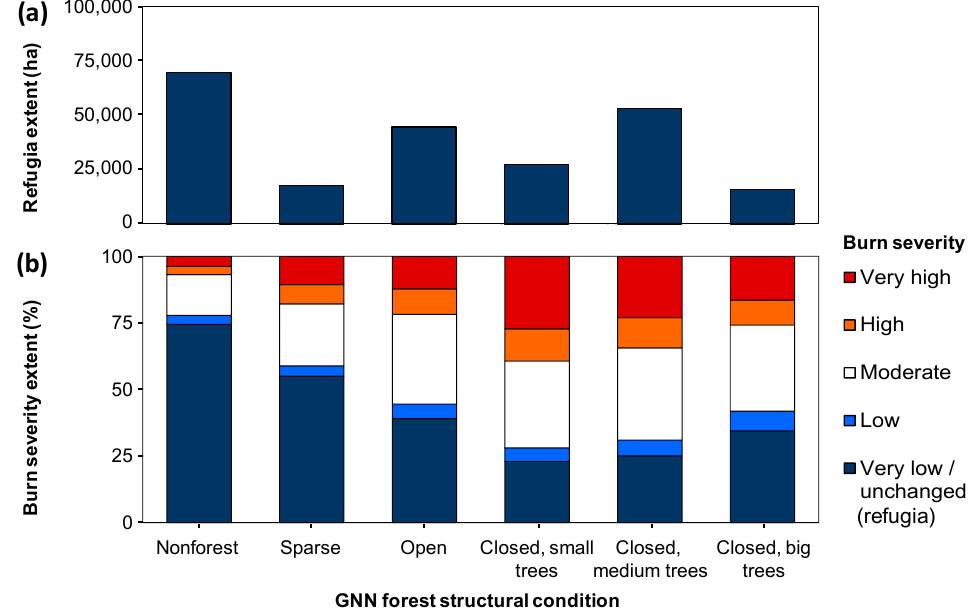
Figure 8. Forest structure of fire refugia in terms of extent of refugia ( a ) and relative distribution of other burn severity classes ( b ). Closed forests (>40% canopy cover) dominated by medium trees (dominant tree diameter 25–50 cm) were the most extensive structural class and contained the most refugia ( a ). The percentage of refugia generally declined with increasing tree cover and size but then increased in closed forests with large trees. Pre-fire structural conditions are based on live tree canopy cover and size classes according to 2003 GNN maps [38]. Structure classes are arranged in increasing order of tree cover and size. See Section 2 for details regarding burn severity and structure classification and Figures 3 and 4 for landscape spatial patterns. We include non-forested areas for reference but do not interpret the severity classes in direct comparison with the forested areas.